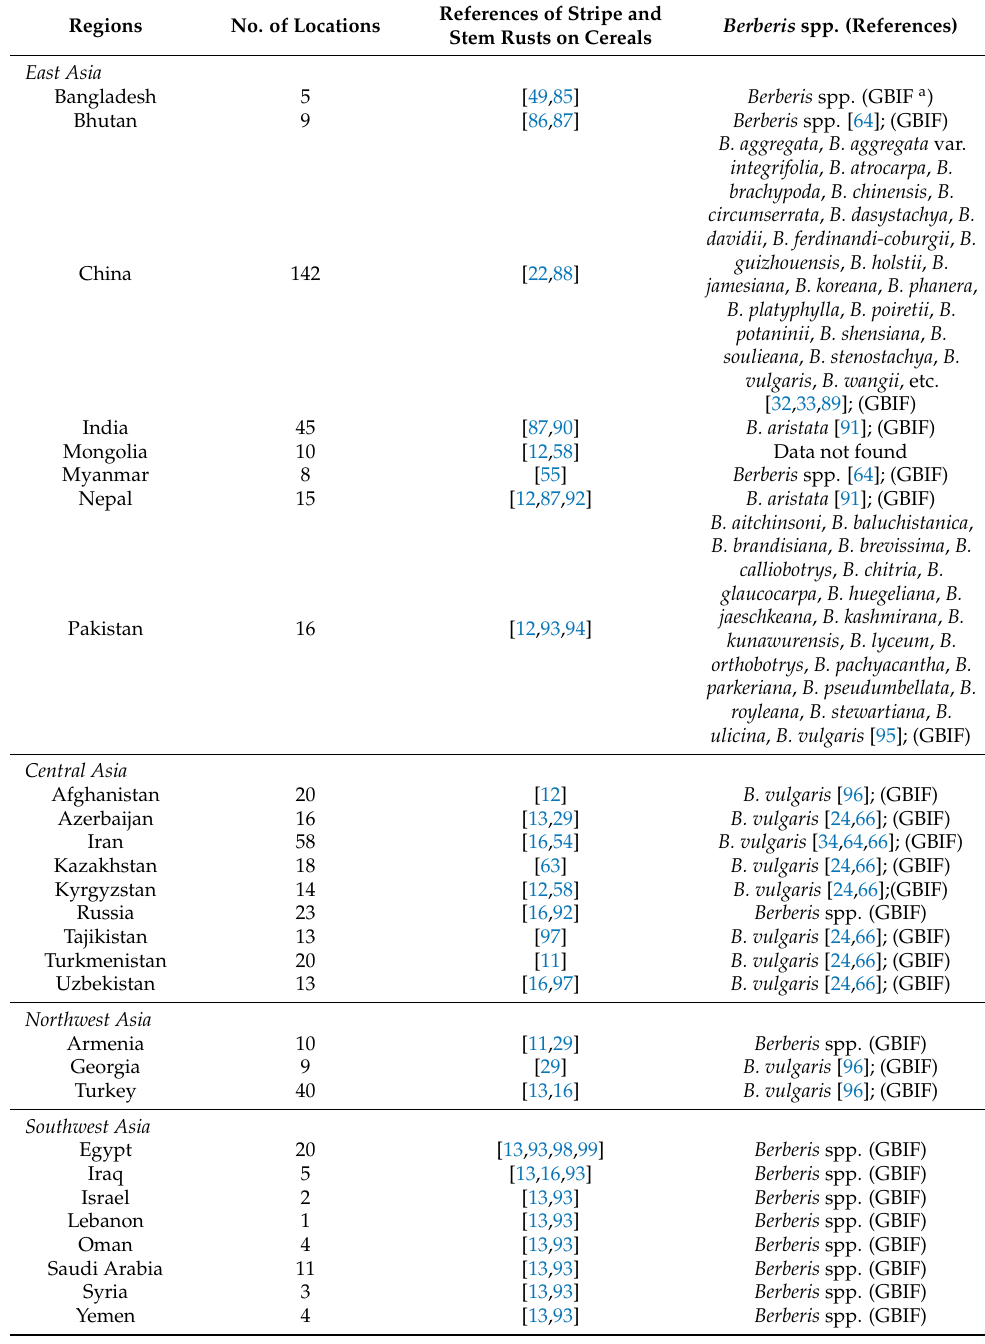
Table 3. Number of sites in Asian and adjoining Southeast European countries selected for assessment of favorable conditions for barberry infection by Puccinia striiformis f. sp. tritici and P. graminis f. sp. tritici , references for the occurrence of stripe rust and stem rust, and presence of Berberis spp. and